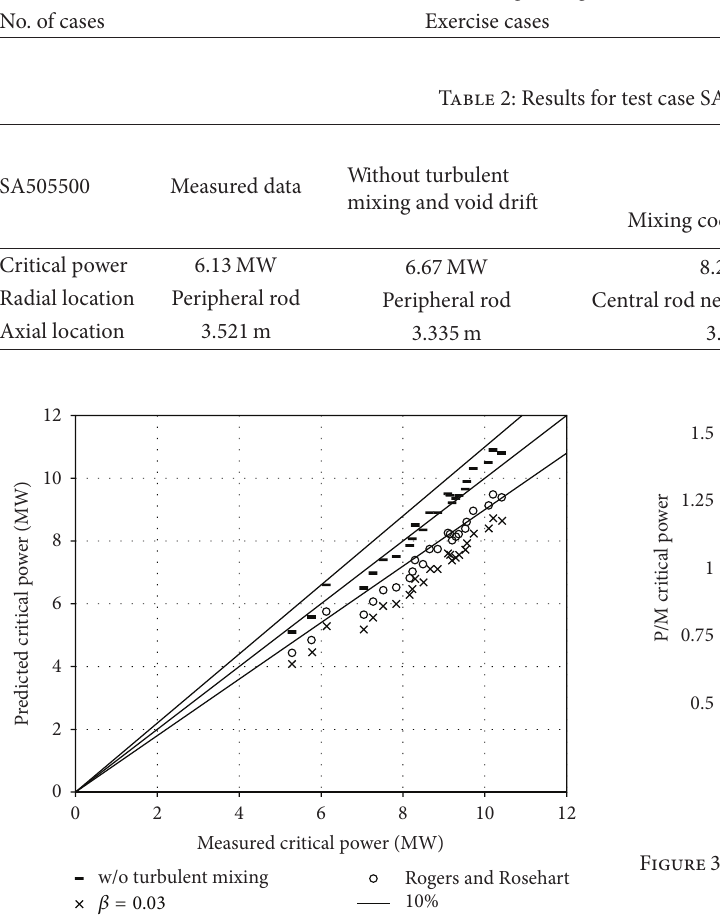
Another observation in the code predictions was the bias with the pressure—the code tends to overpredict the critical power at lower pressure ( 5.5 MPa) and to underpredict it at higher pressure ( 9 MPa). No bias was seen with the �ow rate and the inlet ∼ ∼